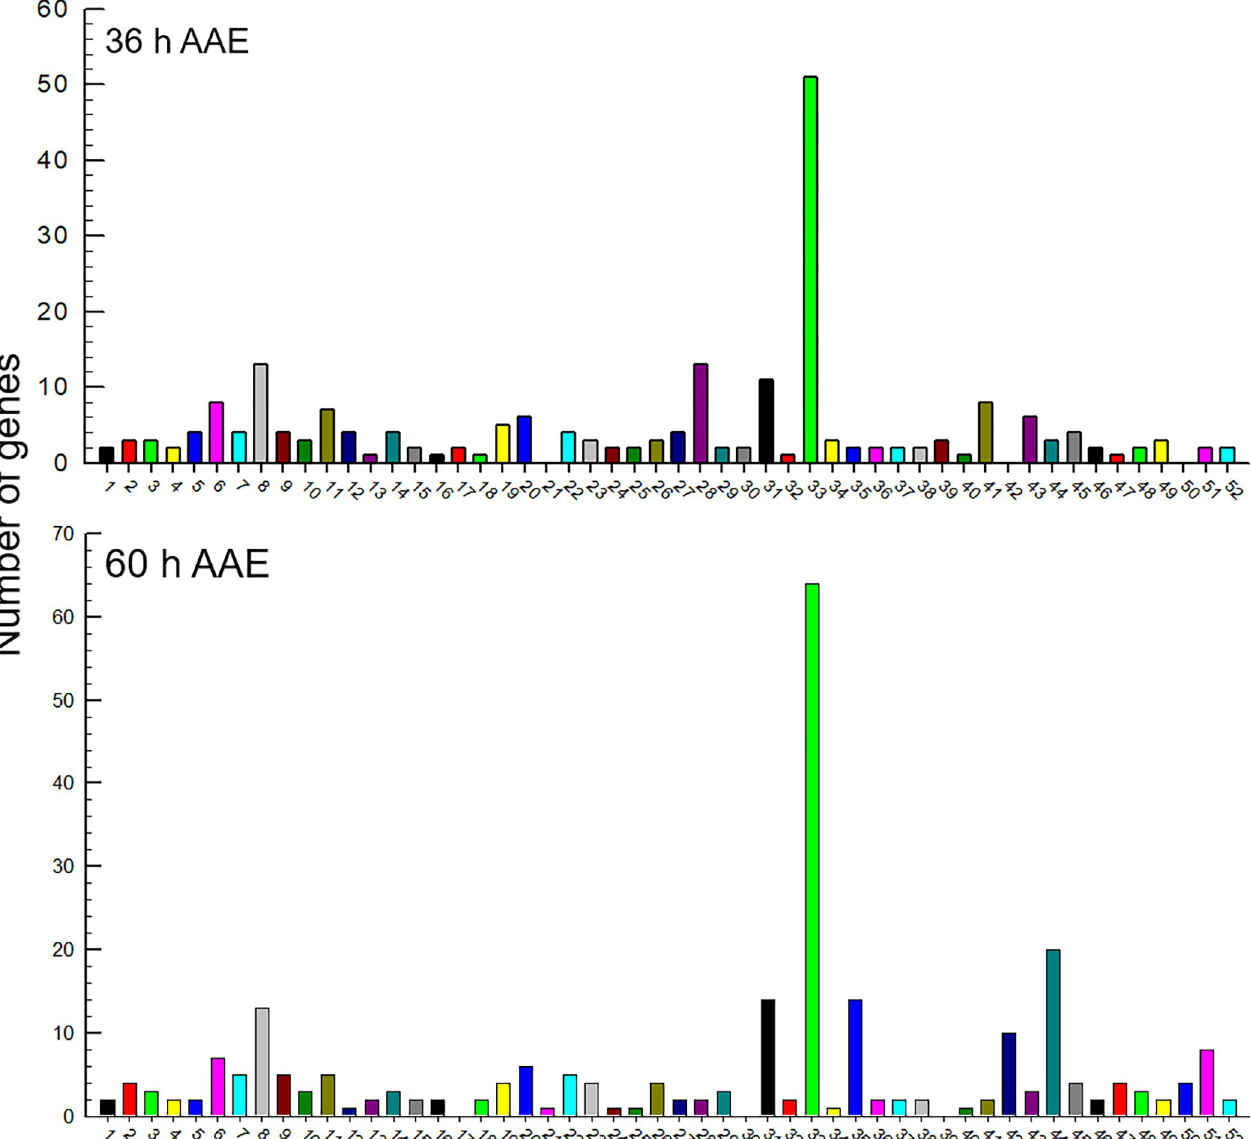
Fig 3. KEGG analysis of the DEGs selected from Fig 2B. The metabolic pathways in the KEGG database were mapped with the DEGs. 36 h AAE represents DEGs between transcripts at 0 h and 36 h after adult emergence and 60 h AAE represents DEGs between transcripts at 0 h and 60 h after adult emergence. KEGG categories include alanine, aspartate and glutamate metabolism (1), amino sugar and nucleotide sugar metabolism (2), apoptosis (3), arachidonic acid metabolism (4), ascorbate and aldarate metabolism (5), autophagy (6), biosynthesis of amino acids (7), biosynthesis of cofactors (8), biosynthesis of nucleotide sugars (9), biosynthesis of unsaturated fatty acids (10), carbon metabolism (11), citrate cycle (12), cysteine and methionine metabolism (13), cytochrome P450 (14), ECM-receptor interaction (15), endocytosis (16), fatty acid biosynthesis (17), fatty acid elongation (18), fatty acid metabolism (19),folate biosynthesis (20), foxO signaling pathway (21), fructose and mannose metabolism (22), glutathione metabolism (23), glycerolipid metabolism (24), glycerophospholipid metabolism (25), glycine, serine and threonine metabolism (26), glycolysis/gluconeogenesis (27), inositol phosphate metabolism (28), longevity regulating pathway (29), lysine degradation (30), lysosome (31), MAPK signaling pathway (32), metabolic pathways (33), mitophagy (34), glycan biosynthesis (35), nicotinate and nicotinamide metabolism (36), nucleotide metabolism (37), oxidative phosphorylation (38), pentose and glucoronate interconversions (39), pentose phosphate pathway (40), phagosome (41), protein export (42), protein processing in endoplasmic reticulum (43), purine metabolism (44), pyruvate metabolism (45), starch and sucrose metabolism (46), steroid biosynthesis (47), thiamine metabolism (48), Toll and Imd signaling pathway (49), various types of N-glycan biosynthesis (50), vitamin B6 metabolism (51), and Wnt signaling pathway (52).